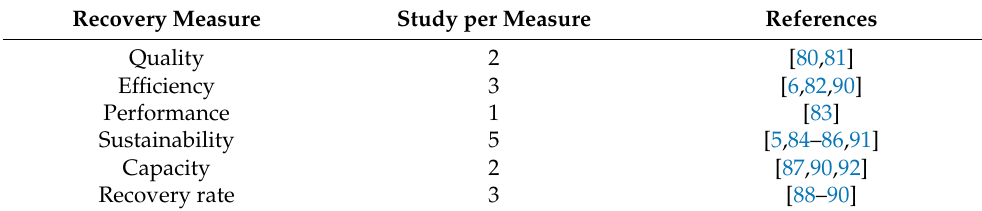
Table 10. Summary of recovery measures.